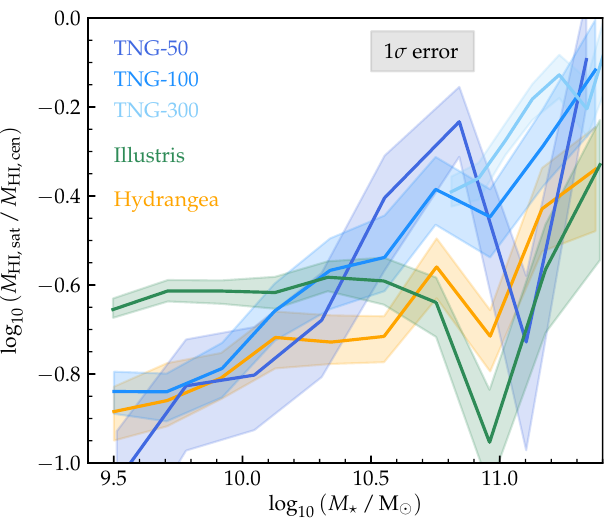
Figure 14. Atomic hydrogen (H I ) deficiency of group satellites compared to centrals of the same stellar mass, as predicted by the Illustris (green), IllustrisTNG (shades of blue), and Hydrangea (orange) simulations (computed following Diemer et al. [305] and Bahé et al. [306], respectively). Solid lines show the difference between mean H I masses in each bin, shaded bands the corresponding 1 σ uncertainties obtained from bootstrapping. All simulations predict H I -deficient group satellites, with the difference generally largest (almost 1 dex) for the least massive galaxies. Note that for IllustrisTNG300 (light blue), H I masses are only computed for all galaxies with M (cid:63) > 5